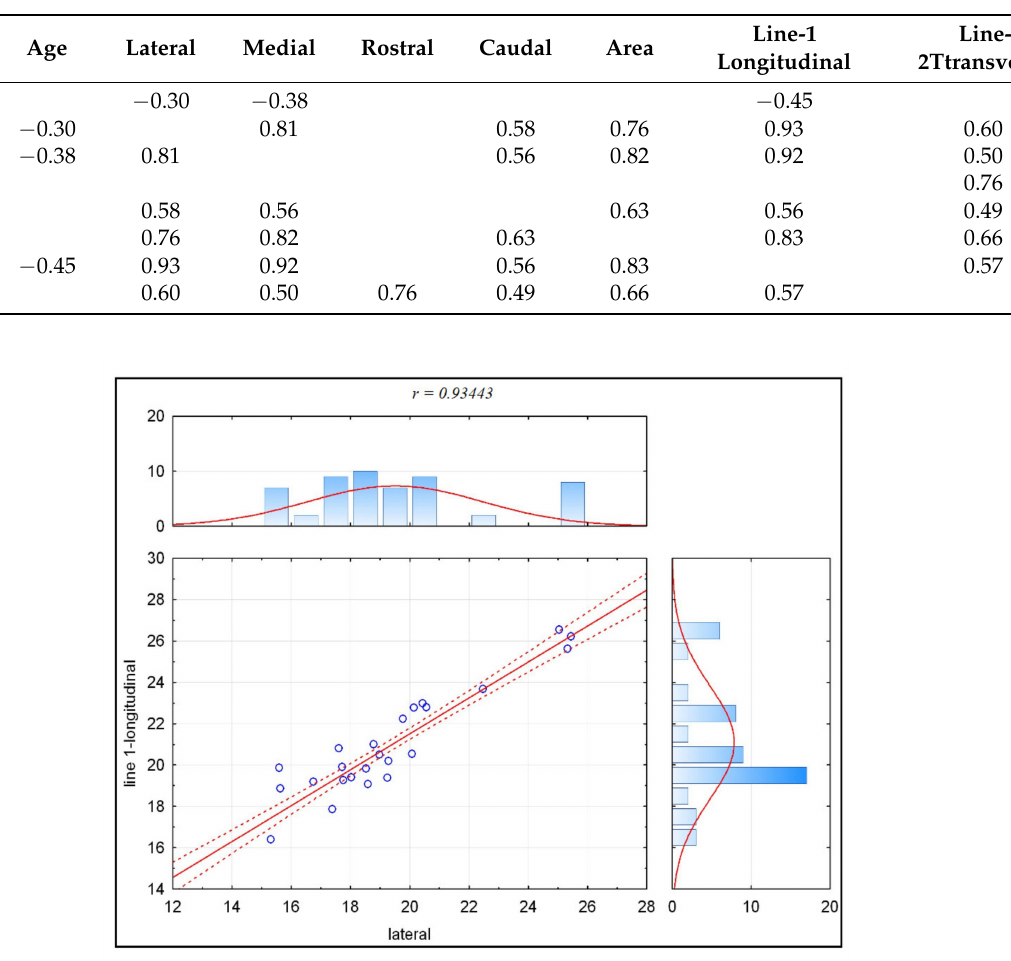
Table 4. The r -value for the male group correlations ( r -value presented only for pairs showing statistically significant correlation, p ≤ 0.05).